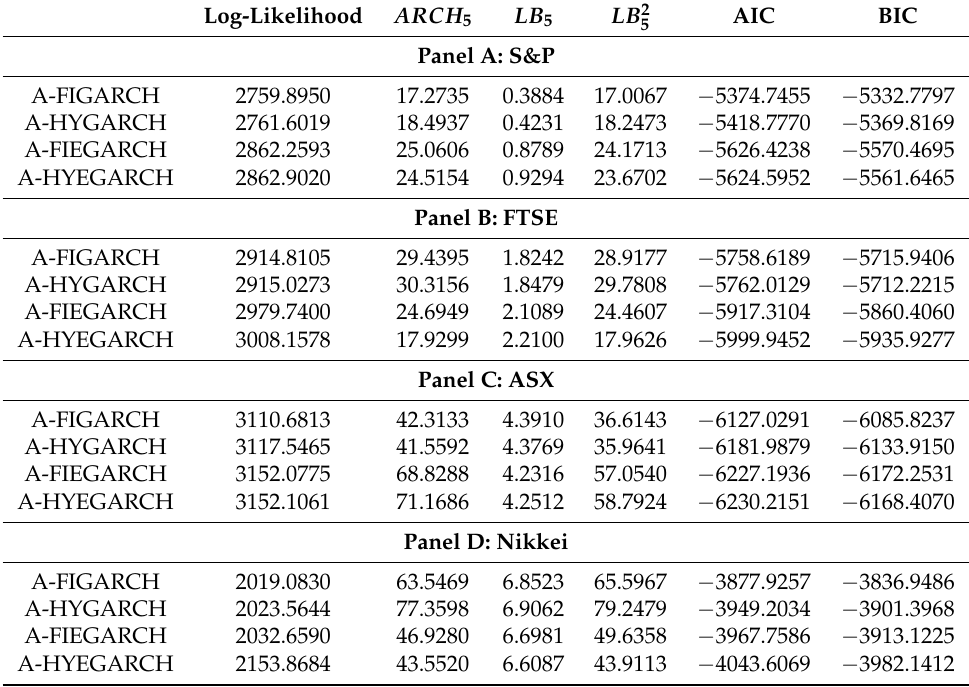
Table 10. Summary of diagnostic statistics and evaluation criteria of fitted adaptive